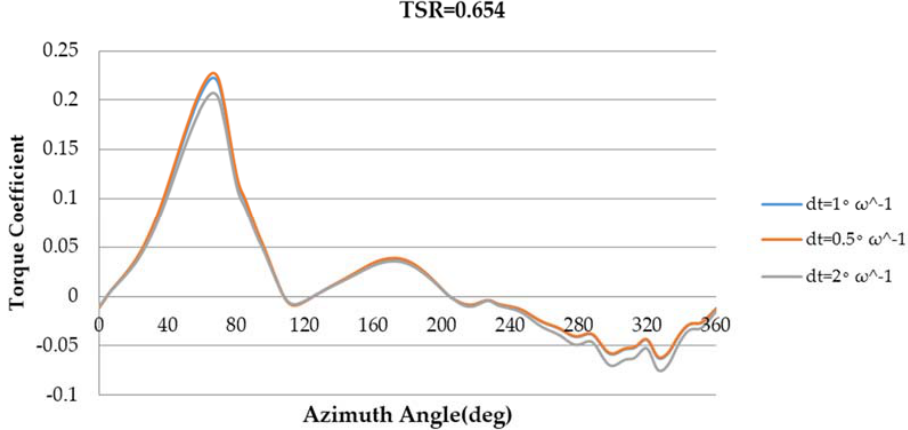
Figure 12. Time dependency study.